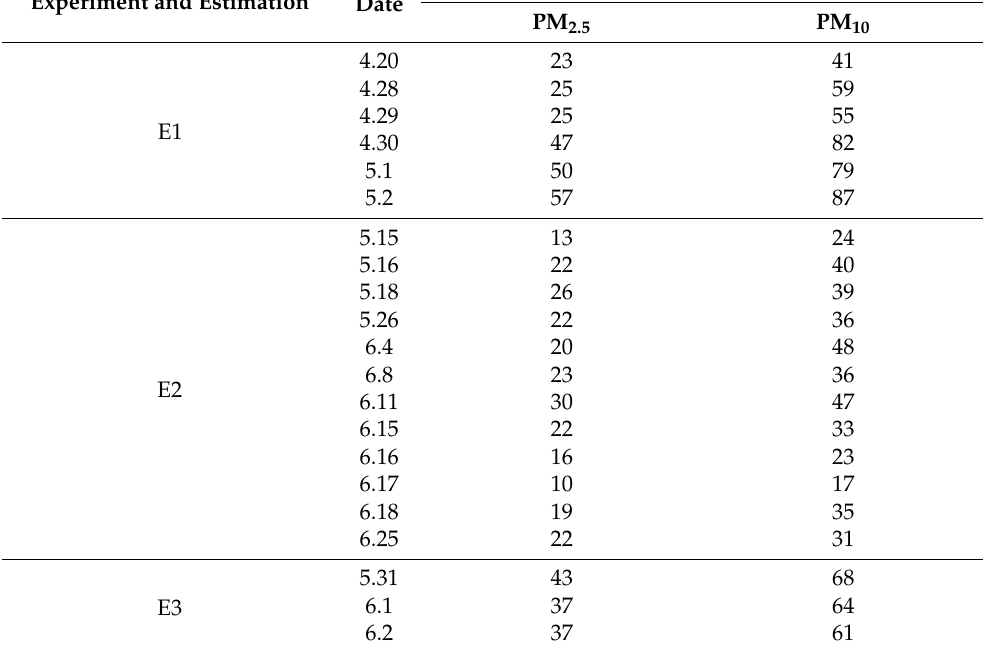
Table A6. Date of experiment and evaluation and corresponding ambient atmospheric PM concentrations. Experiment and